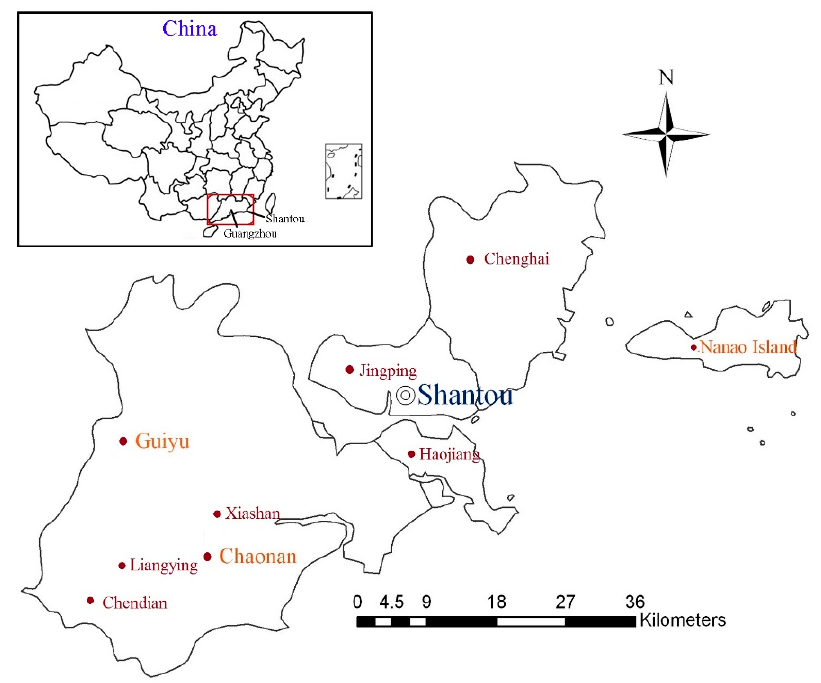
Figure 1. The map of Guiyu and reference areas.